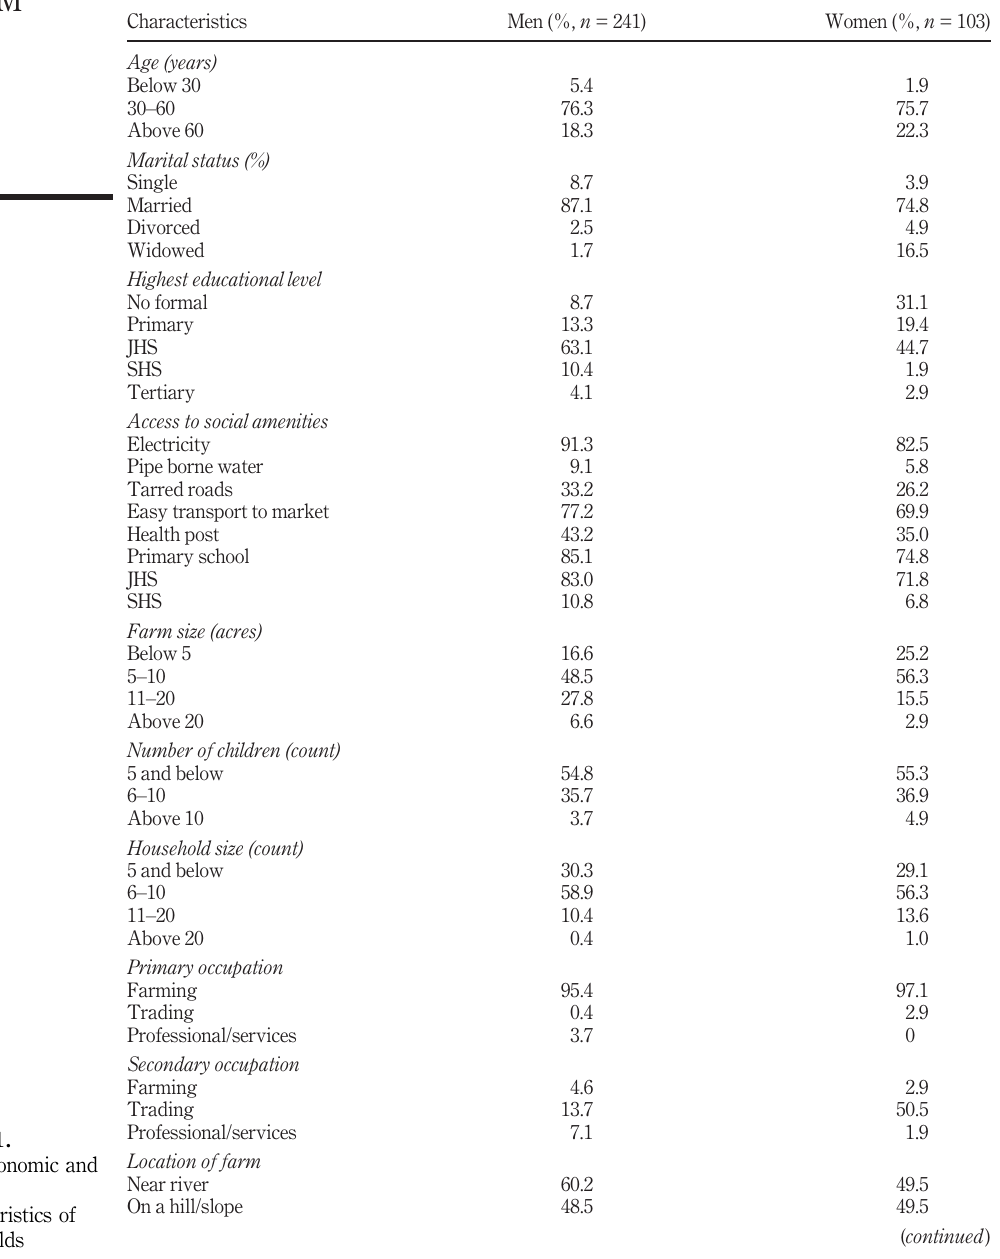
Table 1. Socio-economic and farming characteristics of